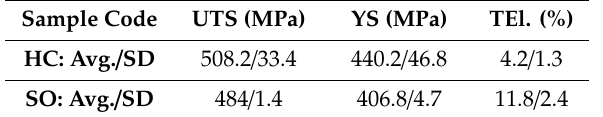
Table 2. Measured tensile properties for hot-forged (HC) and subzero-treated (SO) samples.